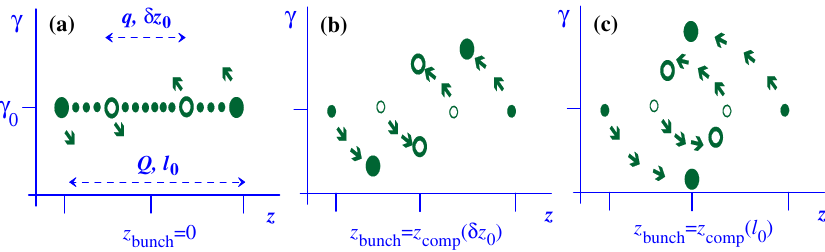
FIG. 6. Different motion of two pairs of electrons, namely, the pair of particles initially placed on the edges of the bunch and a pair of electrons initially placed inside the bunch: (a) initial state, (b) the “ meeting point ” of the inner pair, and (c) the meeting point of the two edge